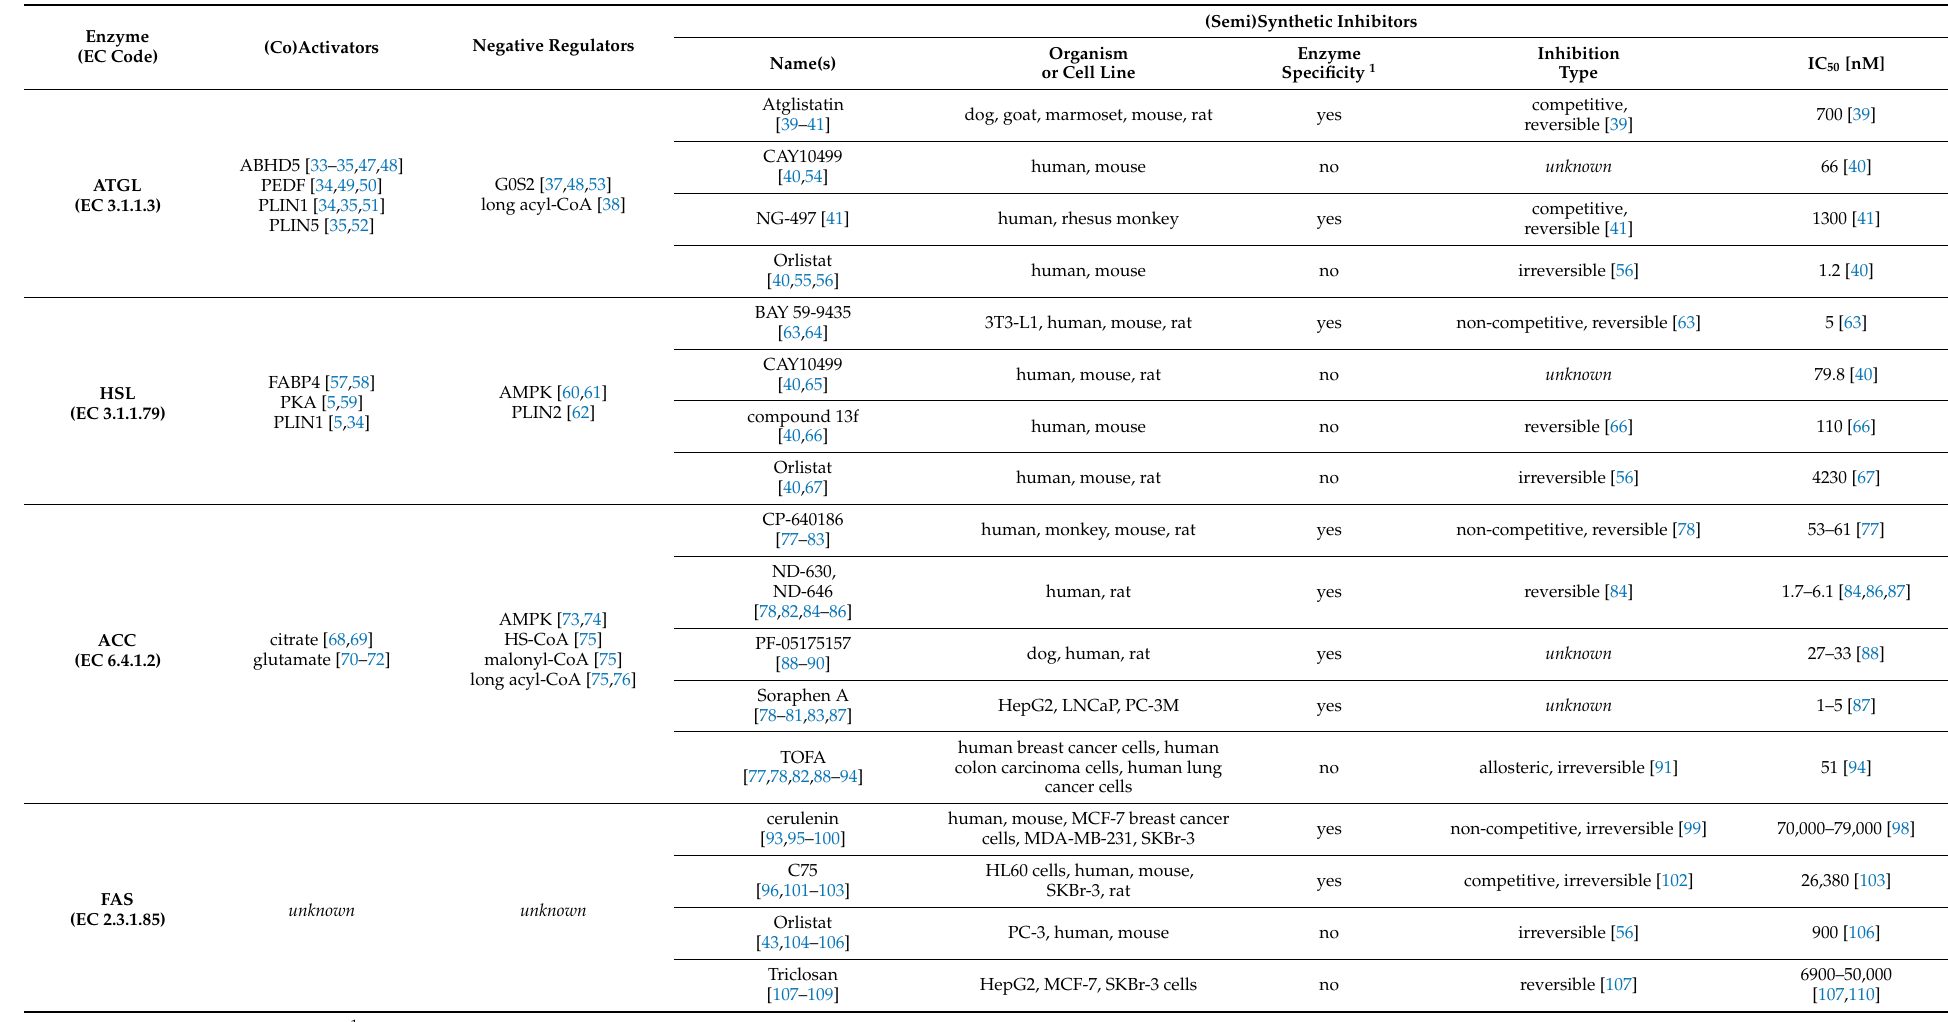
Table 1. An overview of (co)activators and inhibitors of selected lipolytic and lipogenic